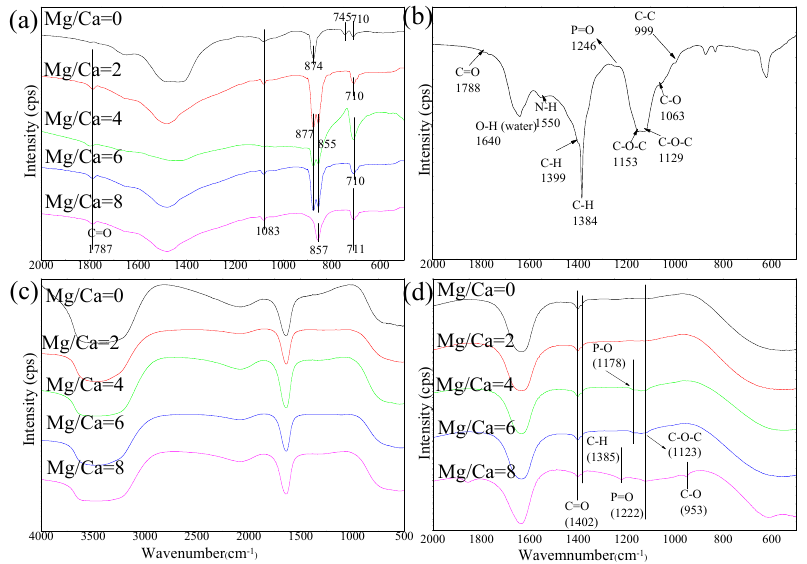
Figure 5. FTIR spectra. ( a ), The obtained biominerals in the experimental groups; ( b ), EPS of YXY2 bacteria; ( c ), Supernatant after the ultrasonic treatment of the biominerals; ( d ), Organic substances within the biominerals.